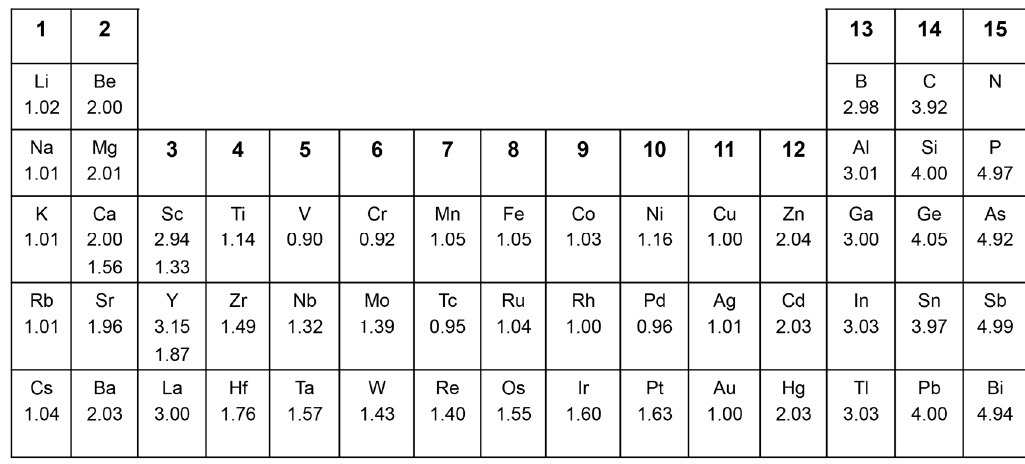
Table 1. e/a for 54 elements in the periodic table.